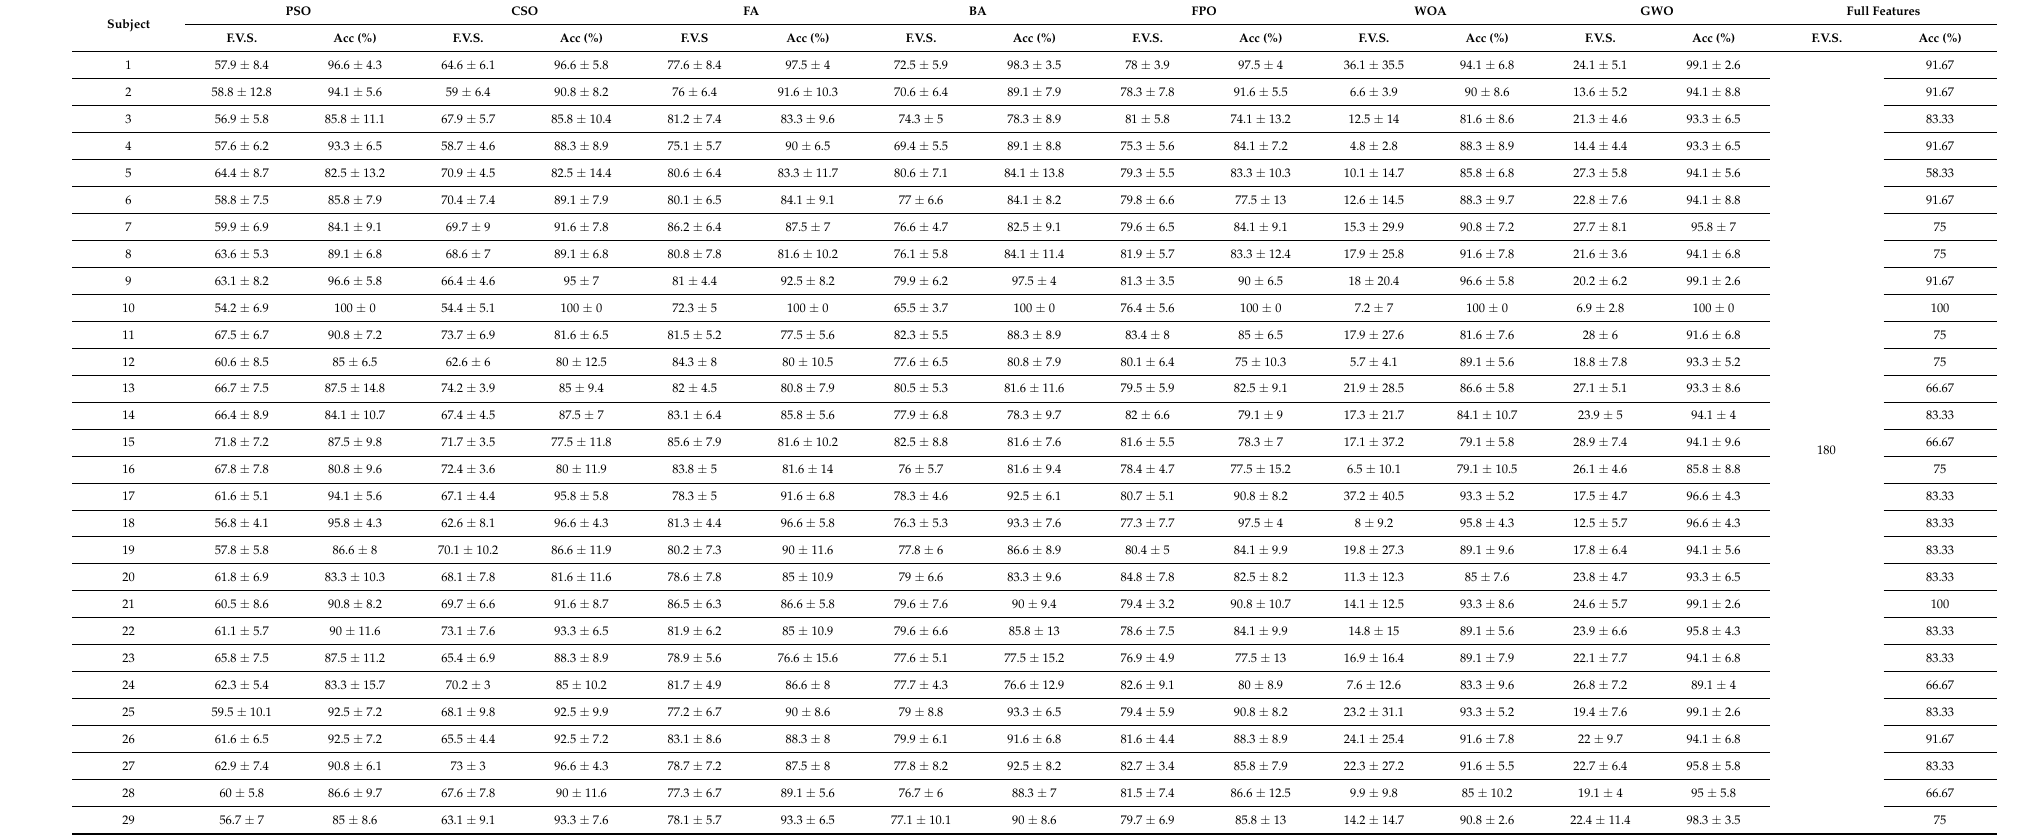
Table 2. Classification performance of each subject for the mental arithmetic (MA) and baseline tasks in terms of the accuracy (Acc) and the feature vector size (F.V.S.) (data represented as the mean ± the standard